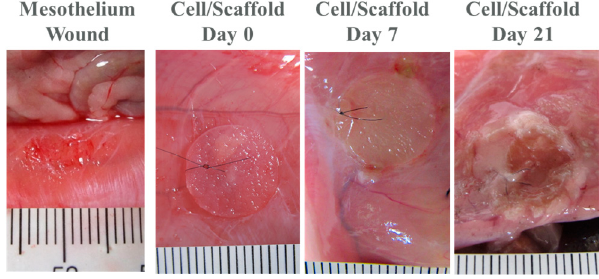
Figure 8. Gross view of the initial mesothelium wound and the transplanted cell/scaffold constructs at different time points post-implantation.